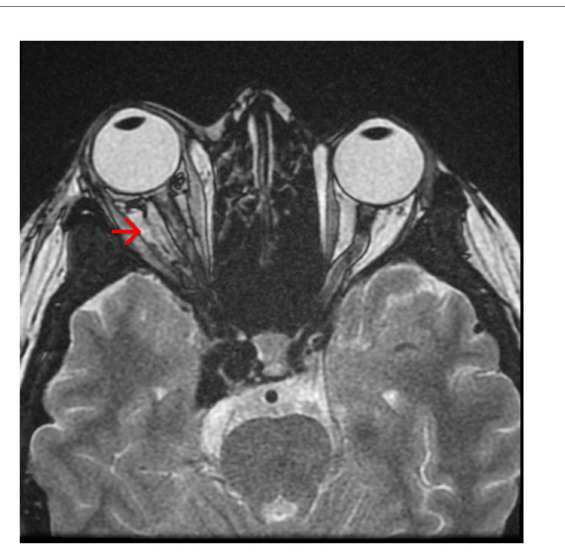
FIGURE 4 Magnetic resonance angiography (MRA) showing axial proptosis and dilation of the superior right ophthalmic vein – see red